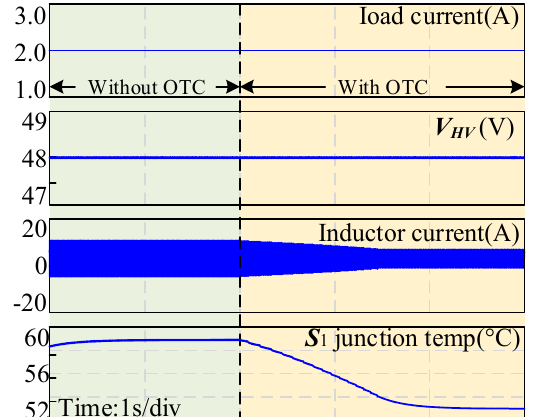
Figure 10. Simulation waveforms of 24 V input voltage to 48 V output voltage for a load current step from 1 A to 2 A with 100 W rated power.